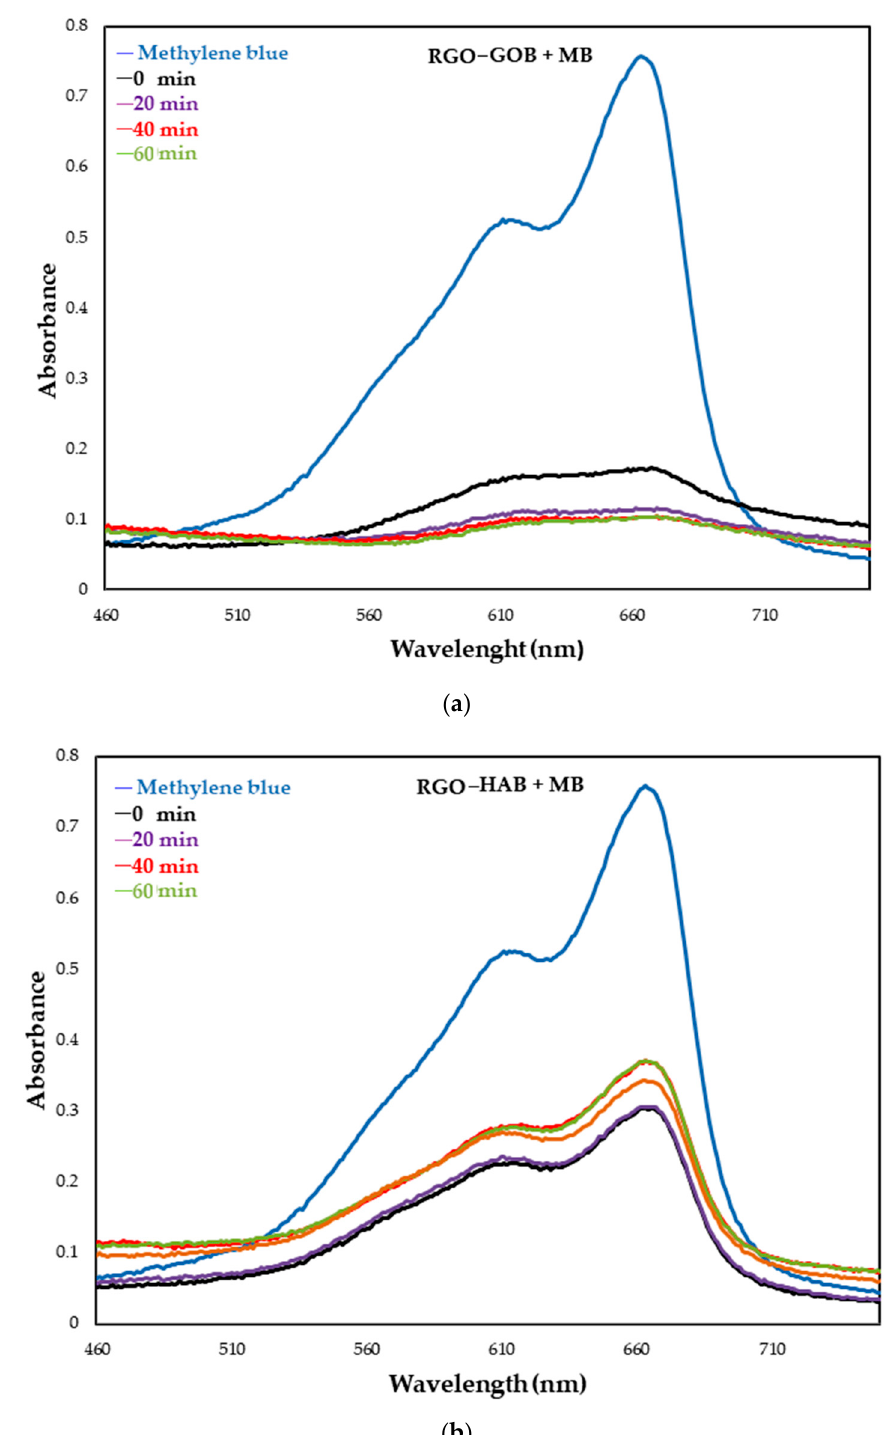
Figure 11. UV–Vis absorption spectra of MB dye solution at different time intervals in the presence of ( a ) ROG–GOB3 and ( b ) RGO–HAB3 under UV light exposure. The degradation efficiency (%) was calculated from the absorbance values obtained for the initial dye concentration (C o ) with the absorbance values obtained at specific time intervals (C t ) (Figure 12).